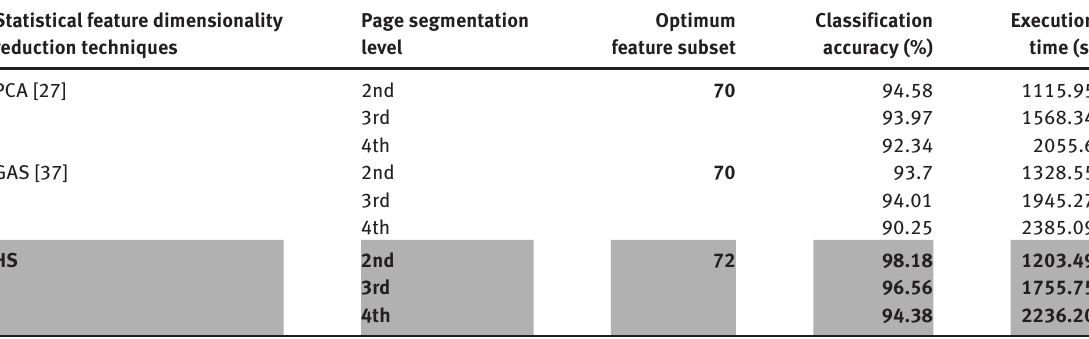
Highest recognition accuracy is shaded in gray and styled in